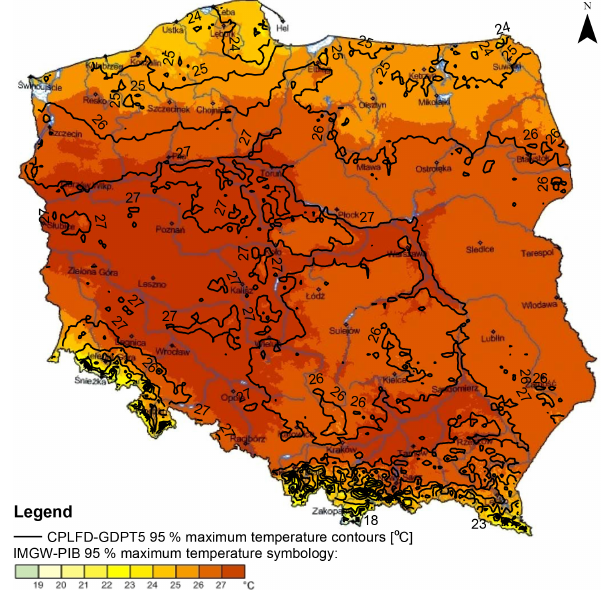
Figure 13. Comparison of CPLFD-GDPT5 5% minimum- temperature contours with IMGW-PIB 5% minimum-temperatures map for the 1971–2000 period. Contours are in 1 ◦ C intervals. The IMGW-PIB map indicates also major rivers (blue lines) and major cities (labelled black circles). The IMGW-PIB map is adapted from the Climatic Maps of Poland (IMGW-PIB, 2015).